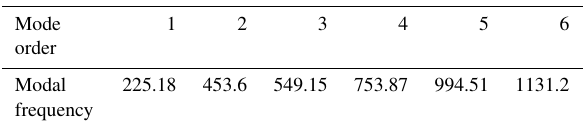
Figure 10. The first-order mode shape of the frame (Hz). Table 3. The sixth-order modal frequencies of the clamping arm (Hz).